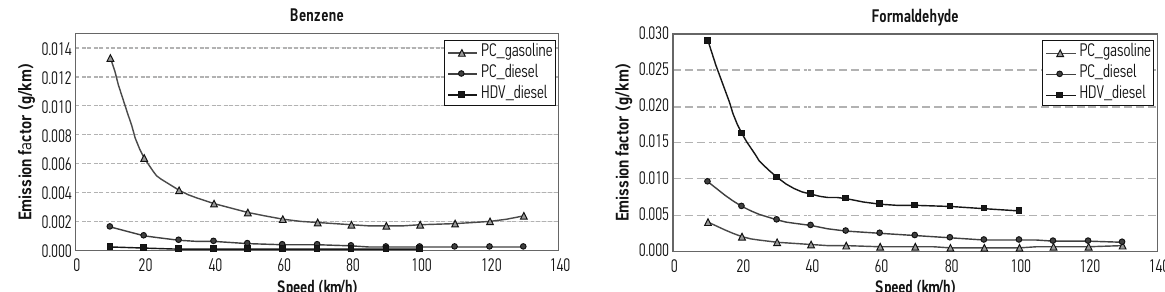
Fig. 2. An example of emission factors for benzene and formaldehyde considered by the emission model for Euro 2 vehicles (PC_gasoline – passenger gasoline cars; PC_diesel – passenger diesel cars with engine capacity < 2 ltr; HDV_diesel – heavy duty diesel vehicles < = 7.5 t) ( d ) [dimensionless]; w – excess emissions at cold 20ºC,20 km/h reference conditions for T = 20ºC and V = 20 km·h –1 [g]; f ( T,V ) – correction factor for speed ( V ) and temperature ( T ) effects; g ( t ) – correction factor for the parking time t.